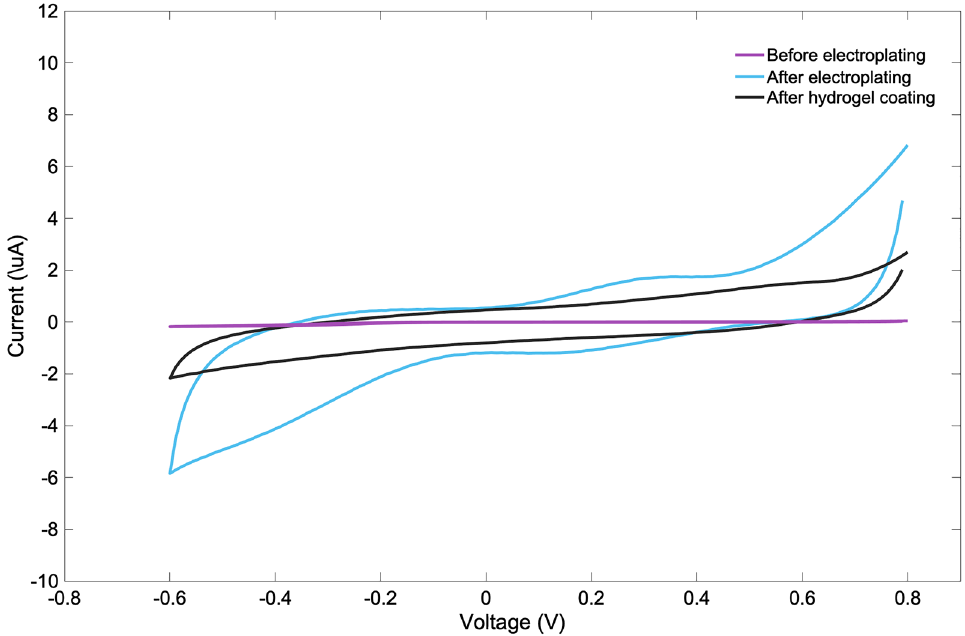
Figure 4. CV of one electrode before (purple) and after (blue) the Pt/Ir electrodeposition, and after hydrogel coating